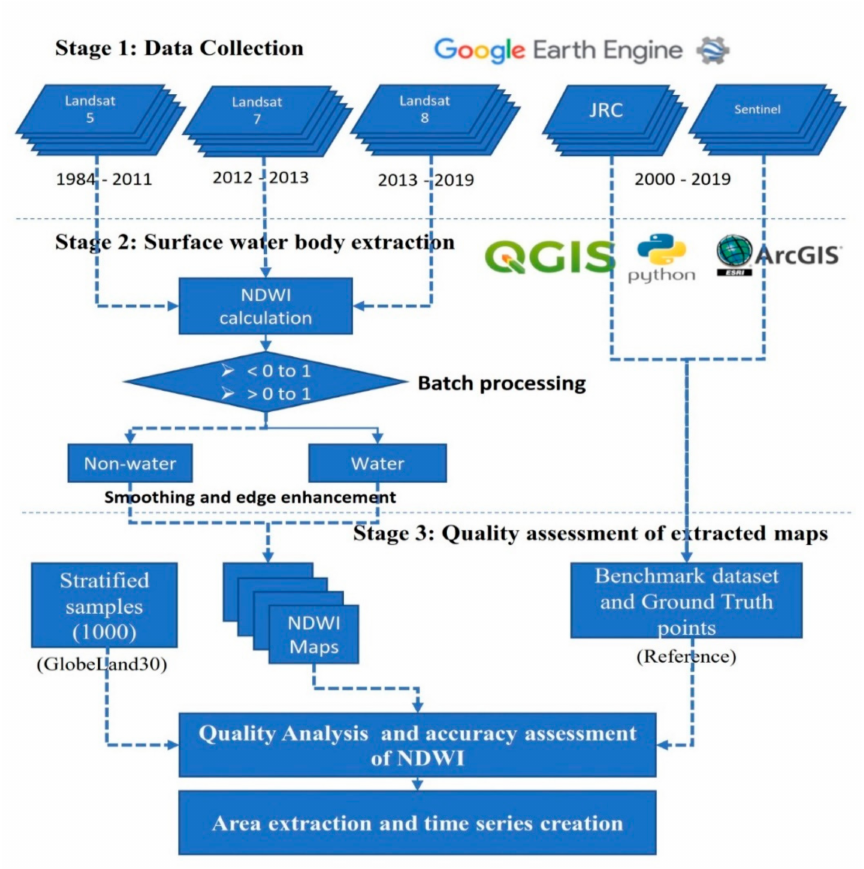
Figure 2. A flowchart of the surface water extraction methodology using Landsat 5, 7, and 8 data utilizing GEE and the ArcGIS model builder